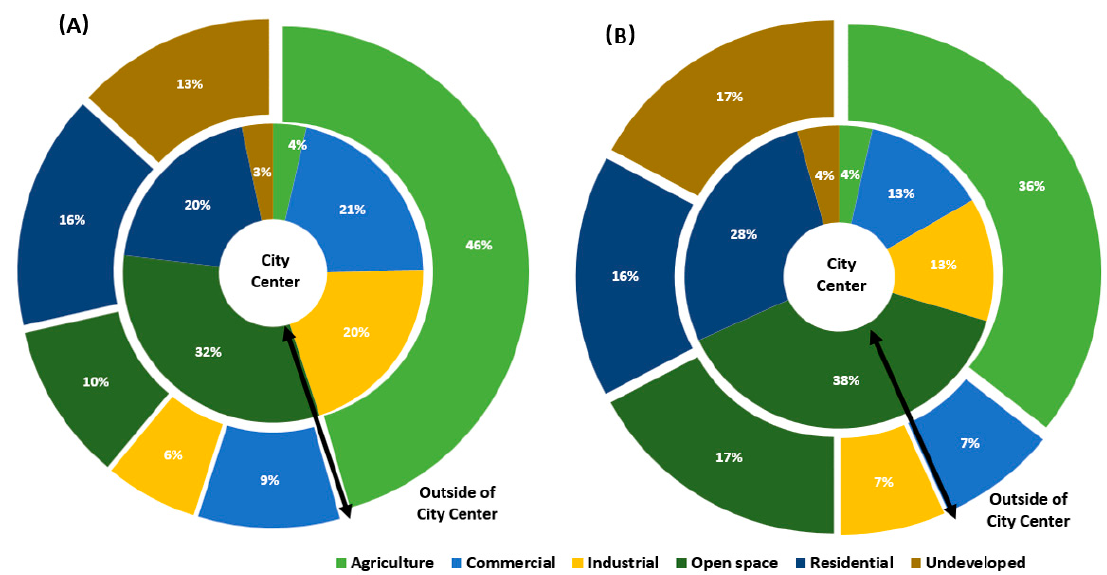
Figure 5. Summary of different land use types in Harvey-induced flooded regions and Federal Emergency Management Agency (FEMA) 100-year floodplains inside and outside of Houston city center areas. ( A ) Land use composition in composite flooding regions, and ( B ) land use composition in FEMA 100-year floodplain